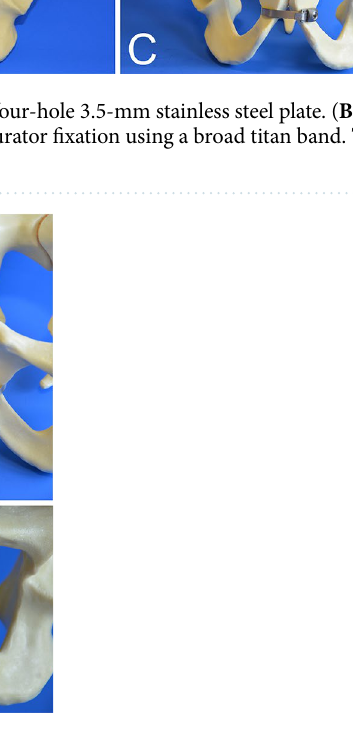
Figure 2. Stepwise application of a trans-obturator fixation in Group C. ( A ) Instruments and titan band ( B ) Tensioner ( C ) Fixation of the clamp using a screw driver ( B ) Final